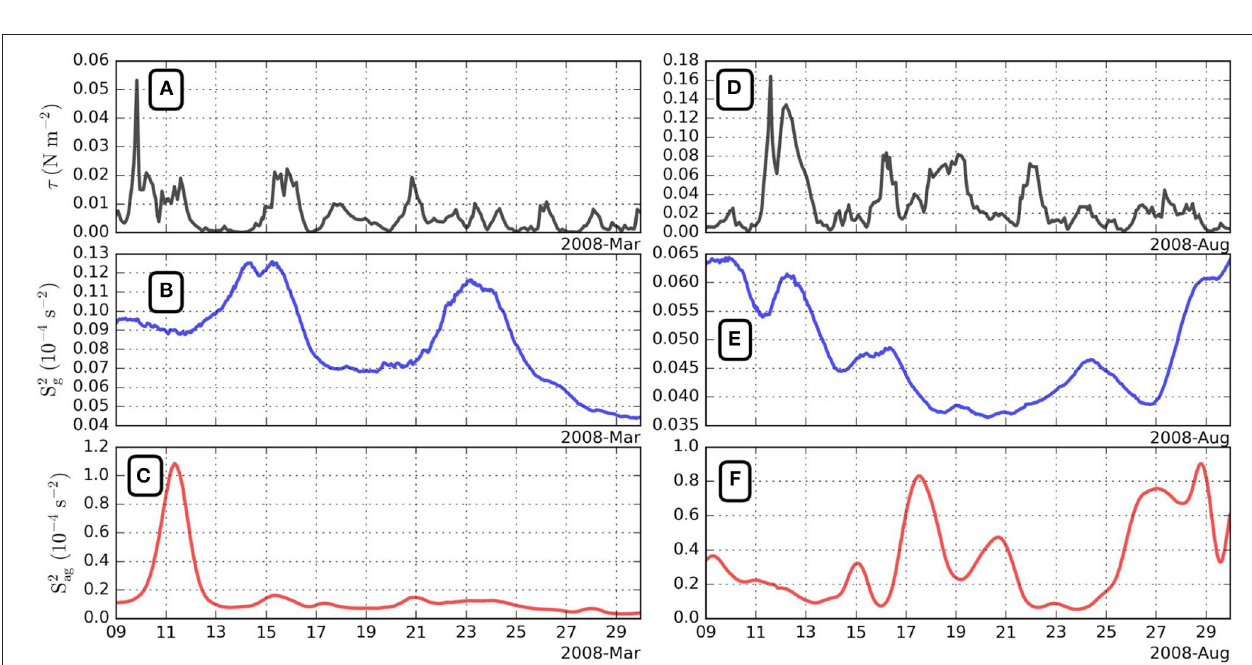
FIGURE 7 | Surface local Rossby number in March (left) and in August (right) 2008. The black dashed box shows the analyzed delimited region in Figures 8 , 12 , 15 . The green and black solid lines show the vertical sections represented in Figures 9 , 10 .